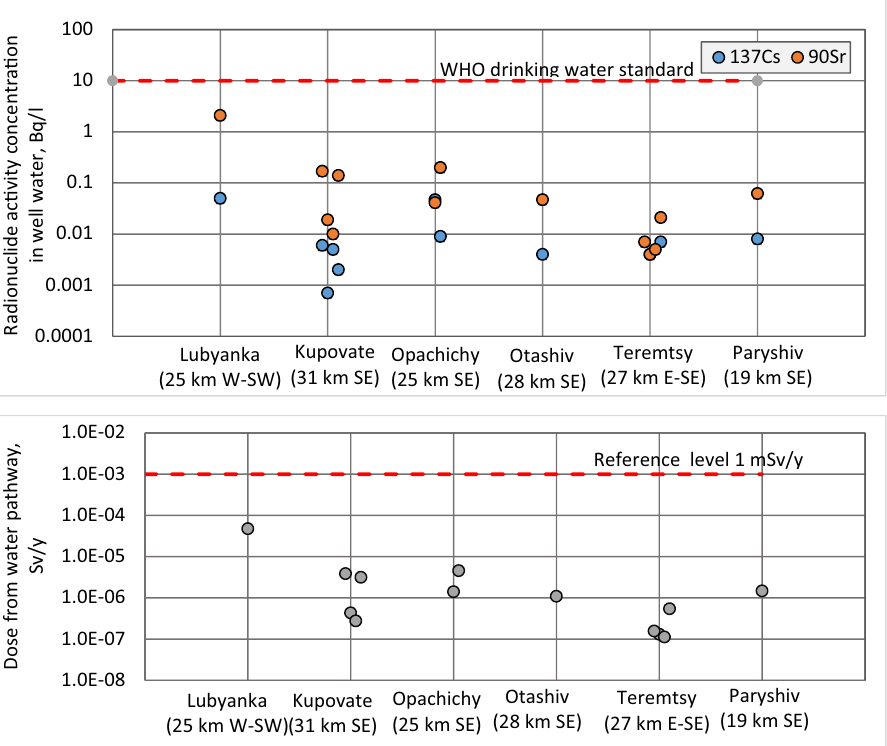
Figure 6. Radionuclide concentrations in the wells used by ‘samosely’ (self-settlers) in CEZ in 2019 and respective doses caused by drinking water consumption. (Map showing location of villages is given in Supplemental Information, Figure S10.2). Analytical errors are within the circular